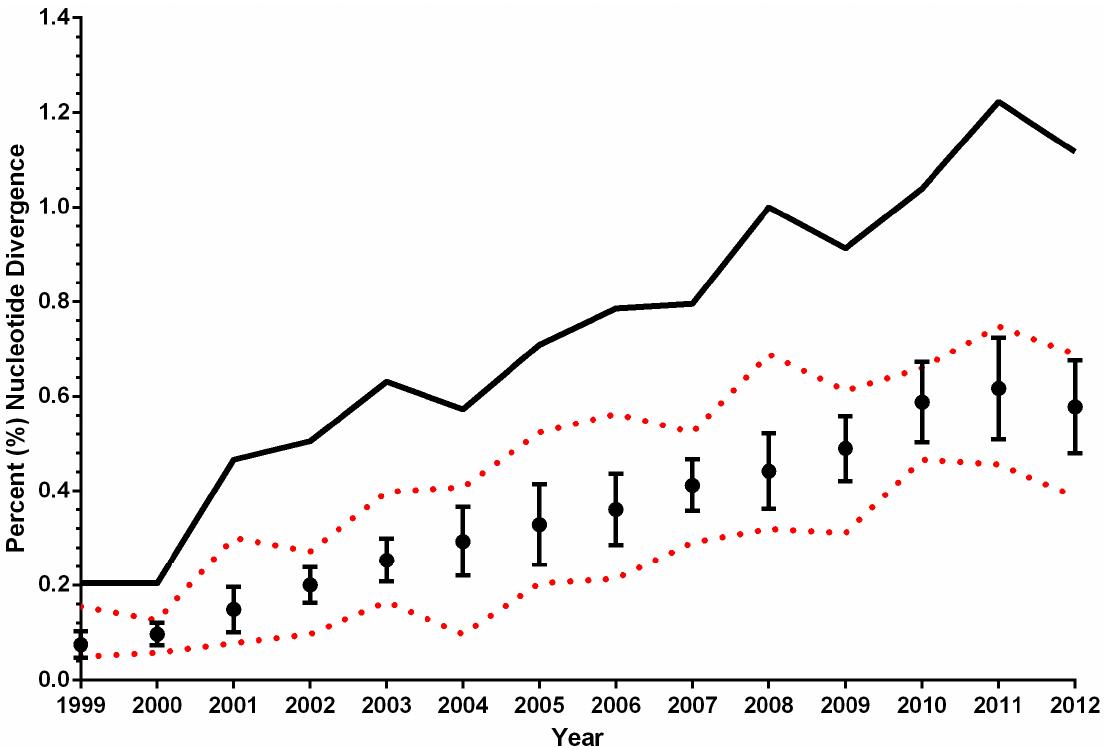
Figure 4. Continued evolution and genetic variation of North American WNV isolates, 1999–2012. North American WNV isolates ( n = 454) published in GenBank between 1999–2012 were compared to the prototype NY99-flamingo382-99 isolate (NY99, AF196835) [32] to determine the average annual percent (%) nucleotide divergence (black dots). Error bars indicate standard error from mean values. Red dotted lines, respective minimum and maximum annual % nucleotide divergence from NY99. Evaluation of overall annual WNV diversity (black line) is demonstrated as the maximum annual % nucleotide divergence between all published virus sequences. Estimates for 2012 included isolates from the 2012 Texas epidemic alone